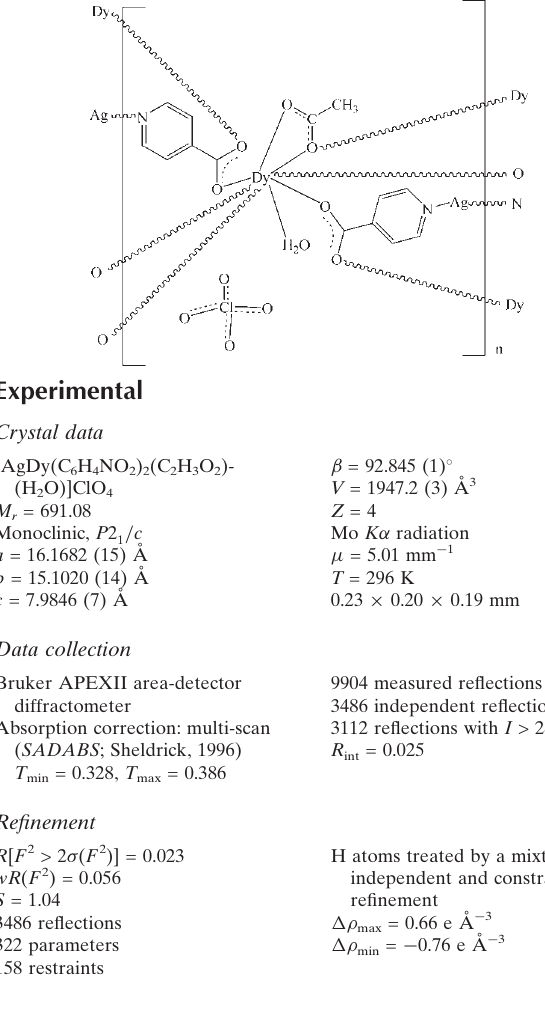
Data collection Bruker APEXII area-detector diffractometer